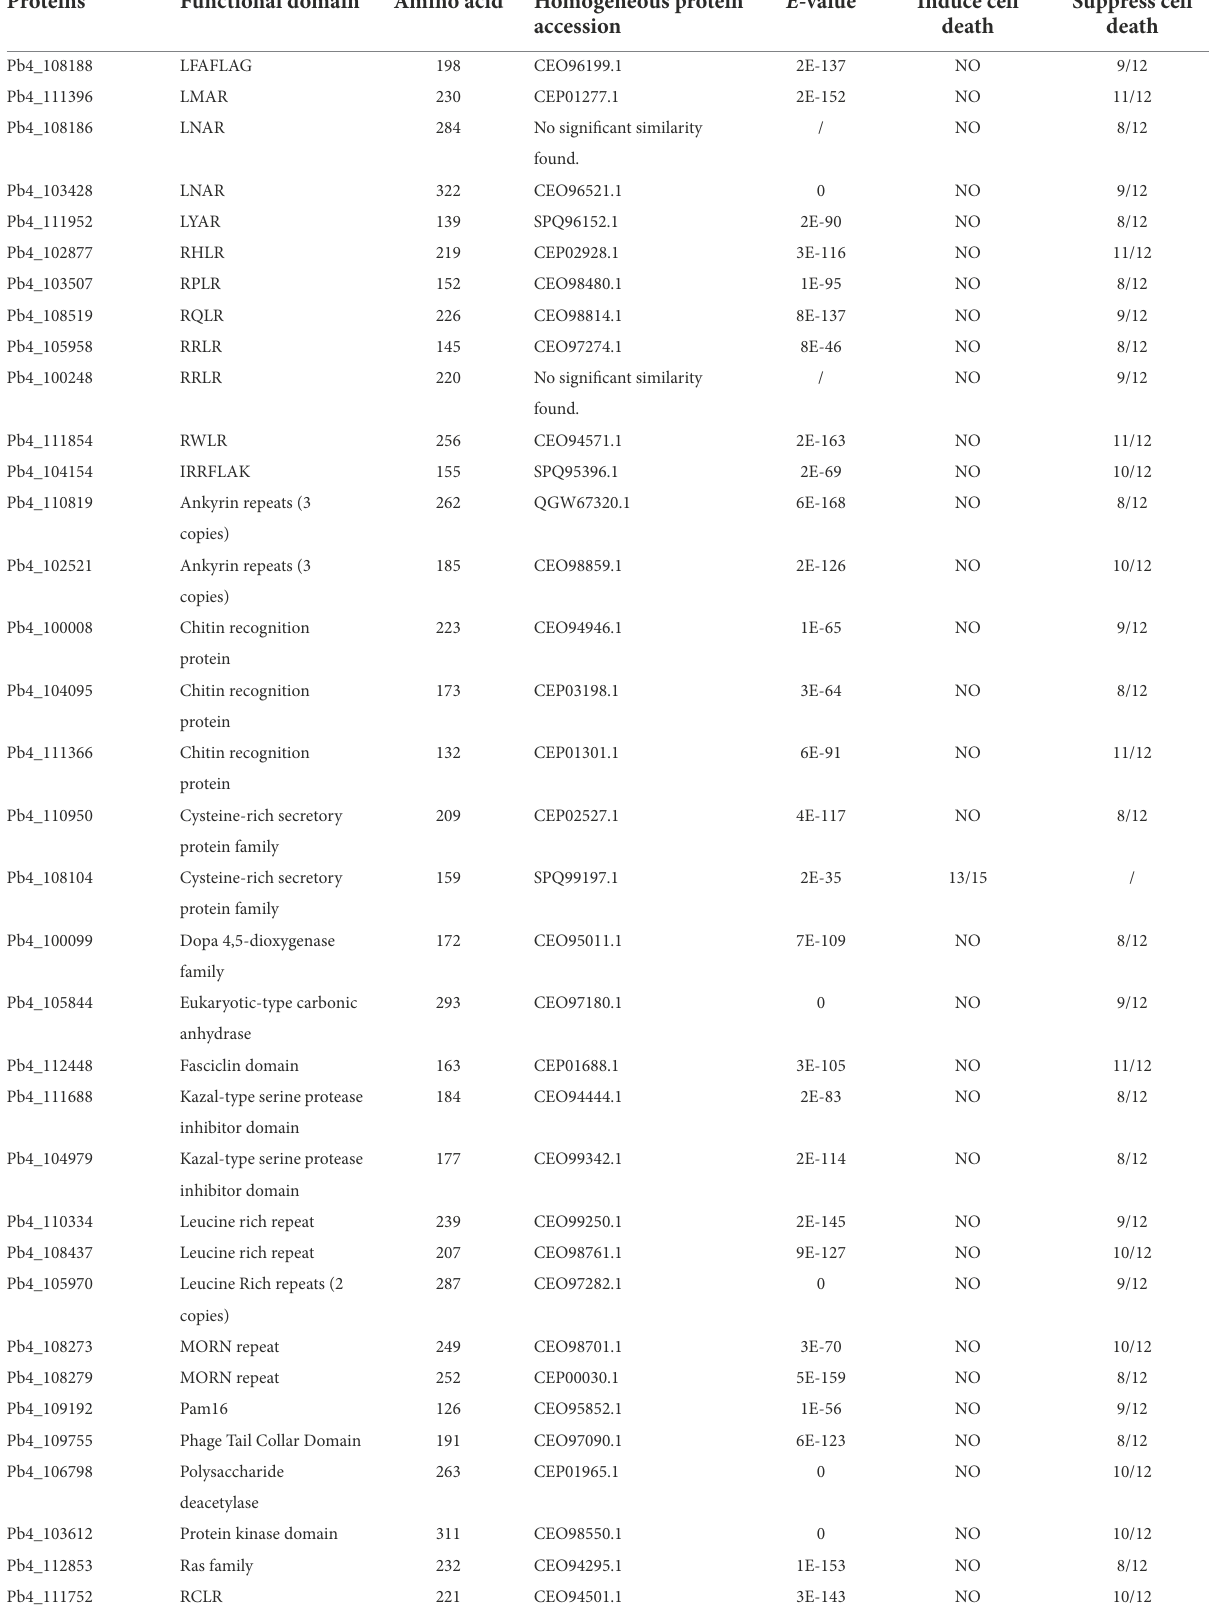
TABLE 1 Details of putative effector